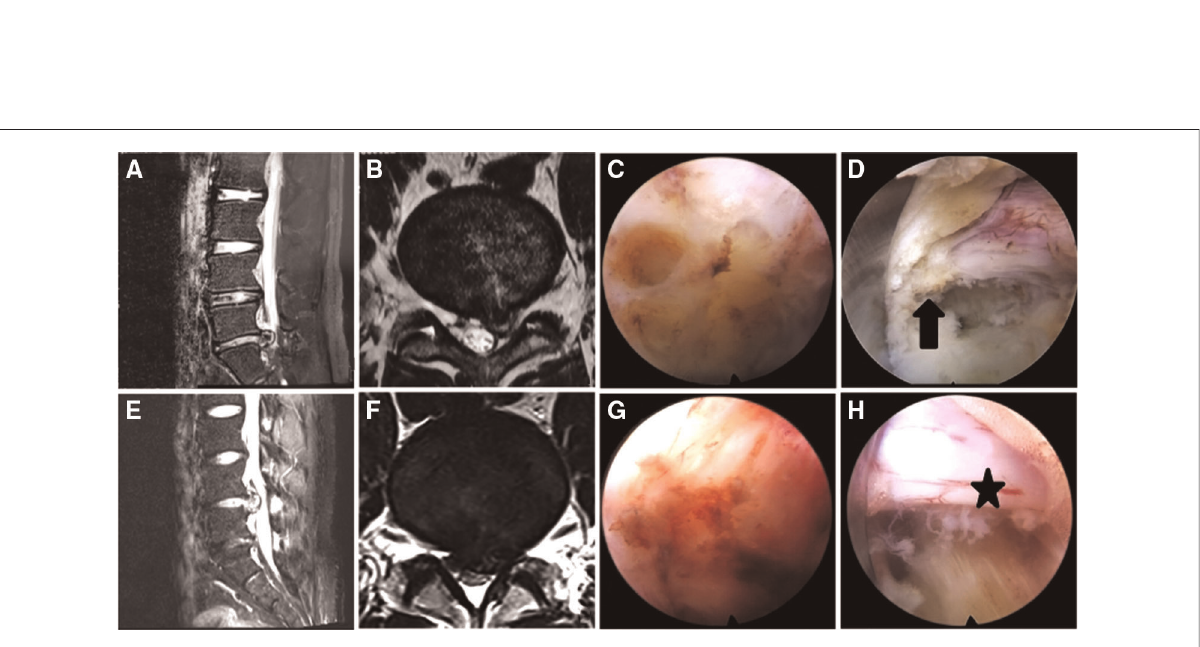
FIGURE 7 Magnetic resonance imaging (MRI) and intraoperative photographs in a PEID group patient with recurrent disc herniation ( A – D ) and a MF-PELD group patient with recurrent disc herniation ( E – H ). ( A,B ) Left L4 – 5 disc herniation is shown on MRI. ( C ) Scarring is present and the local anatomy is poorly de fi ned. ( D ) The surface of the nerve root appears rough and is surrounded by scar (arrow). ( E,F ) Left L4 – 5 disc herniation is shown on MRI. ( G ) Less scarring is seen during surgery. ( H ) The nerve root has clear boundaries and is surrounded by little scar (star) and no adhesive